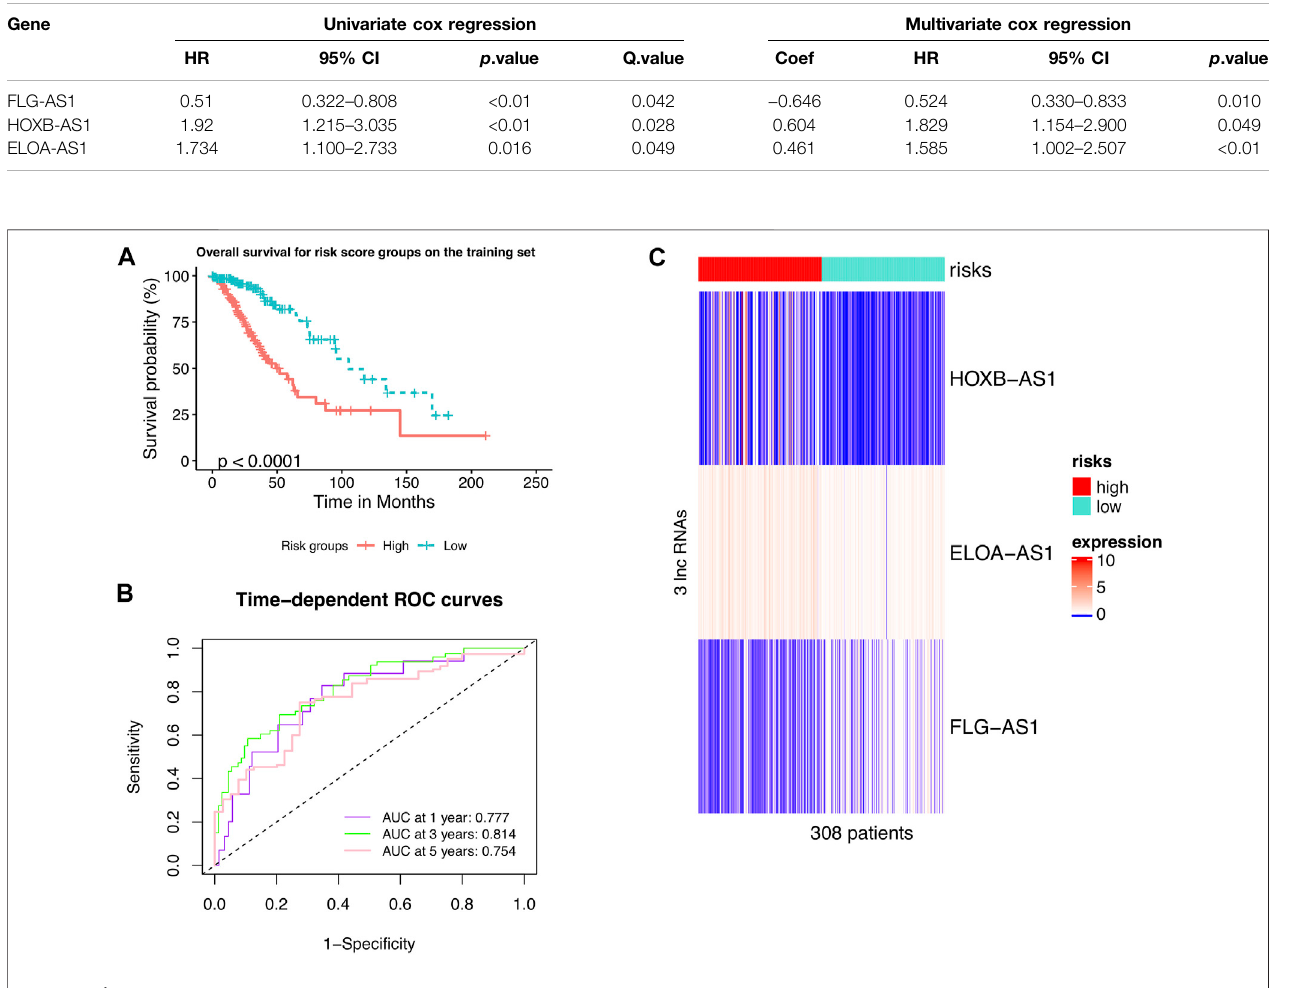
FIGURE1| LncRNAssignatureofthem6Amodi fi cationusedtopredictoutcomesinthetrainingset. (A) Kaplan-Meiercurveofm6ALncSig-predictedOSoflow-or high-risk patients in thetraining set. (B) Time-dependent ROC curves of m6ALncSig at one, three, and 5 years. (C) Variations in expression levels of the three hub m6A- LncRNAs between the two risk